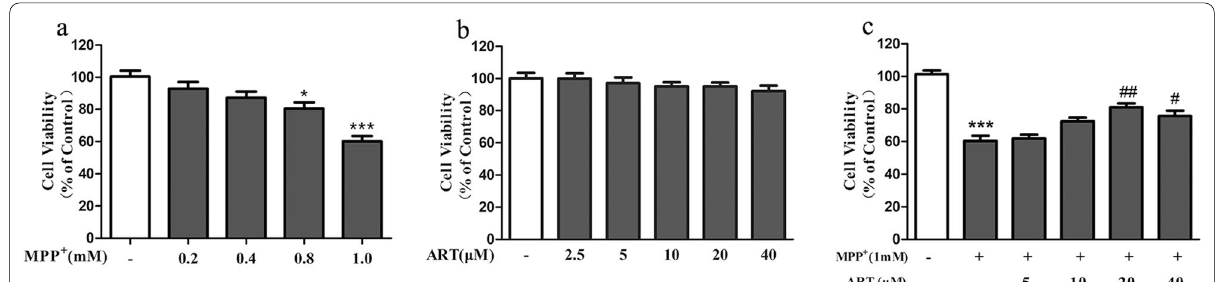
Fig. 1 ART reduced the MPP + -induced cytotoxicity in SH-SY5Y cells. a Effects of different concentrations of MPP + on the viability of SH-SY5Y cells. b Effects of different concentrations of ART on the viability of SH-SY5Y cells. c Effects of different concentrations of ART on the viability of MPP + -treated SH-SY5Y cells. The results are presented as the mean